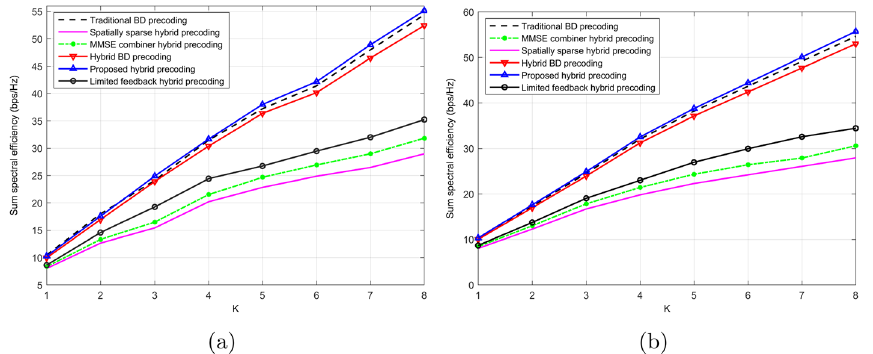
Fig. 4 Achievable spectral efficiency comparison against the number of users K in ( a ) mmWave channel; ( b ) Rayleigh channel